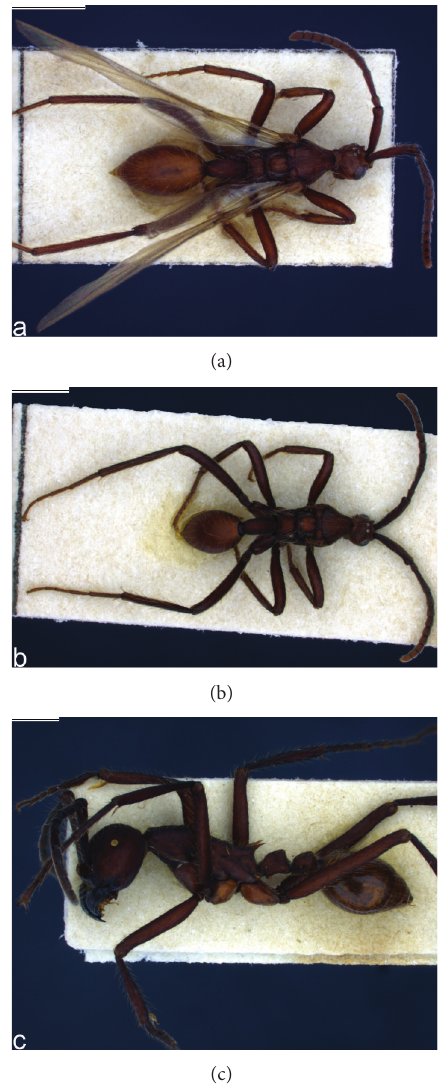
Figure 4: Notoxoides pronotalis female in dorsal view: (a) alate and (b) dealate specimens. Scale: 1 mm. (c) Eciton dulcium collected with Notoxoides pronotalis , in lateral view . Scale: 1